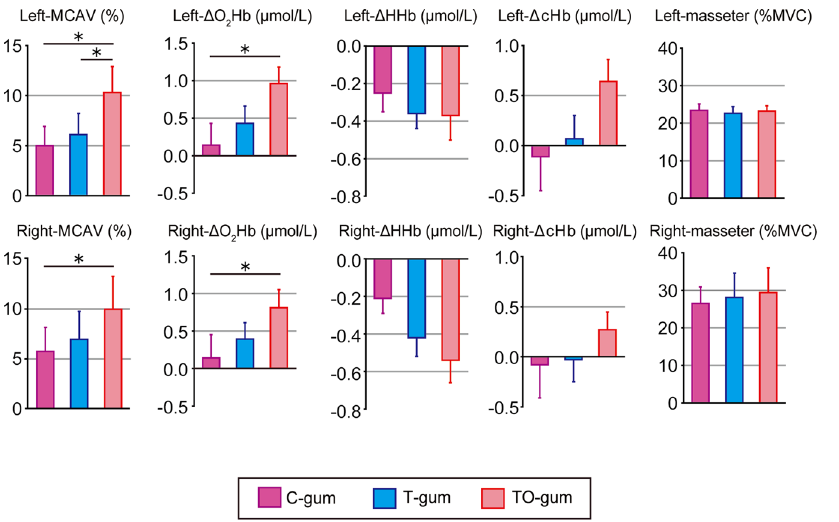
Figure 4. Summaries of hemodynamic changes in the left (top panels) and right (bottom panels) cerebral hemispheres and masseter EMG activity associated with chewing of three different types of gum. In the hemodynamic changes, MCAV, D O 2 Hb, D HHb, and D cHb are arranged from the left to the right. Individual data (mean 6 SEM) are represented as change rates of the responses between gum-chewing tests (5 min) and before the test. Statistical comparisons were performed among the three gums. *P , 0.05, **P , 0.01.